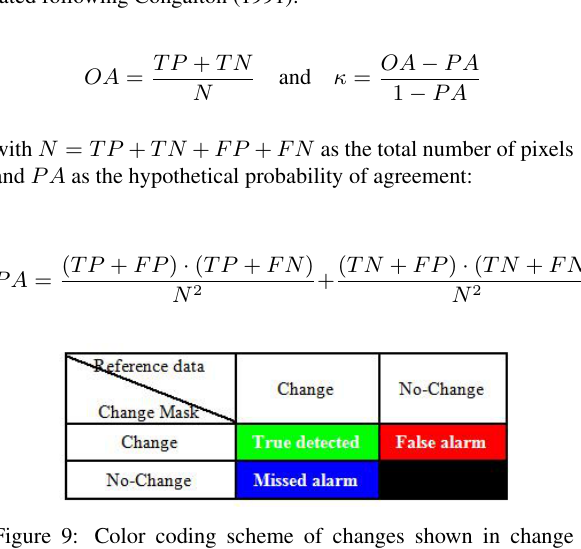
Figure 11: Cartosat ortho images of a forest area near Oberam- mergau 2008 (left) and 2009 (right) 2013). To analyze the changes the height changes from the DSMs and robust multi-level change features from the images are